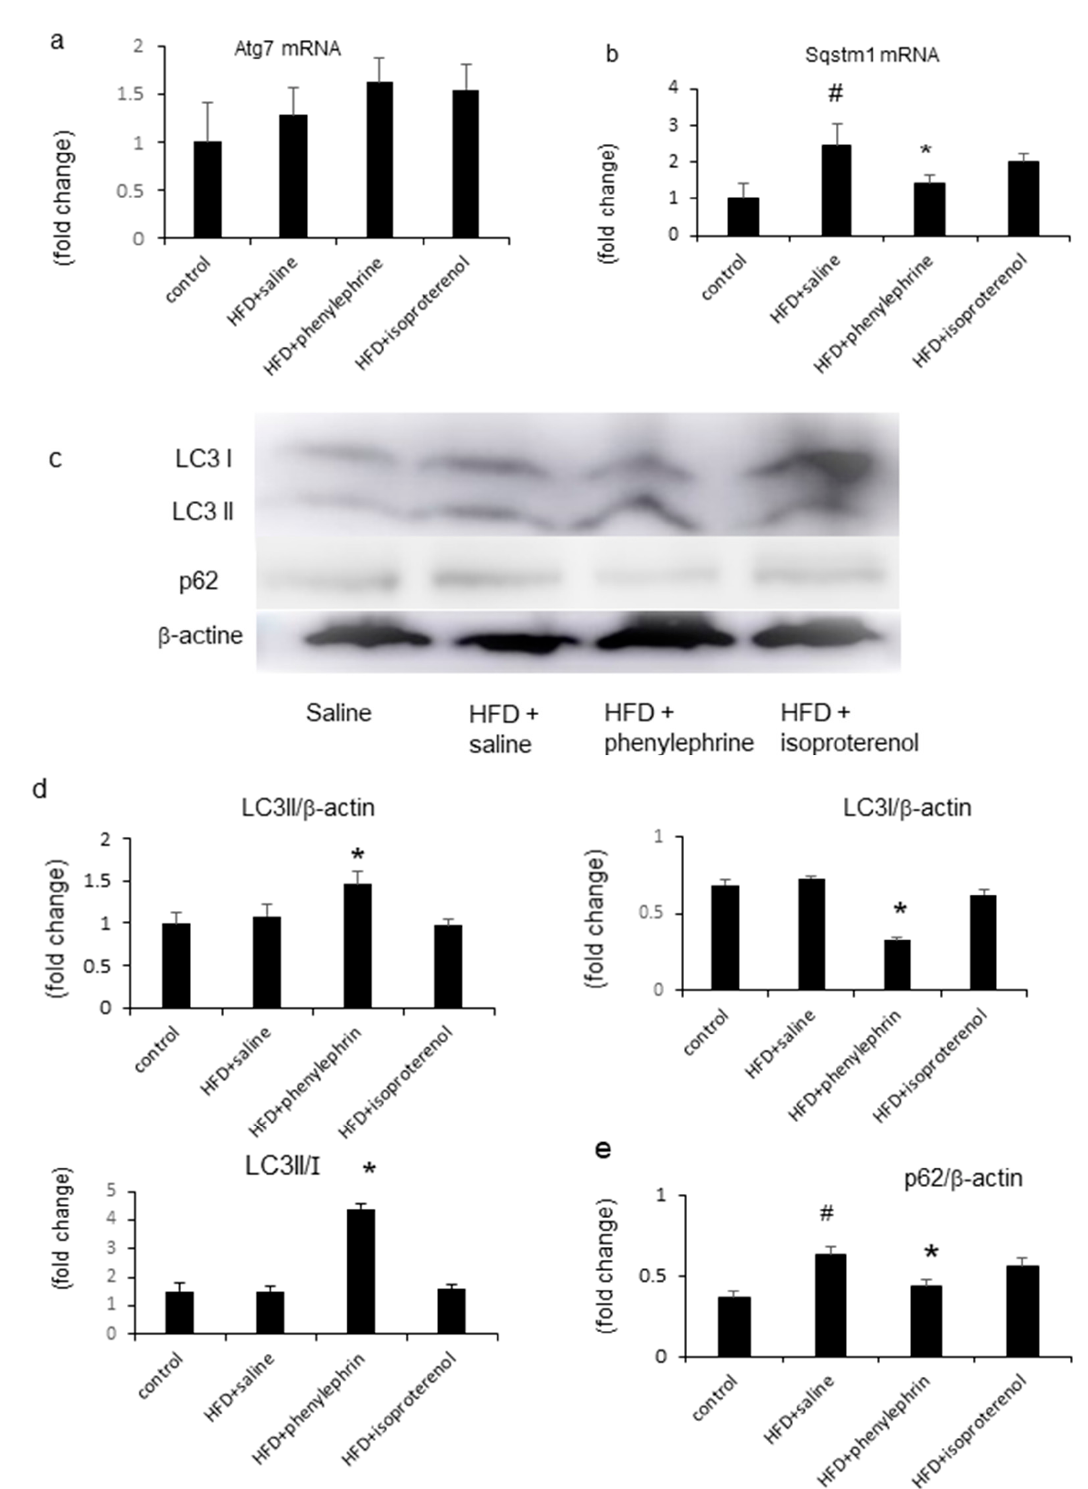
Figure 5. Evaluation of hepatic autophagy-related parameters. Relative mRNA expressions of Atg7 ( a ) and SQSTM1 ( b ). Western blotting autoradiograph images ( c ) and levels ( d , e ) of LC3 and p62 autophagy-related proteins in mice. Statistical analysis was performed using ANOVA. Data are expressed as means ± SE. # p < 0.05 for HFD with saline group compared with the control group. * p < 0.05 for HFD with phenylephrine group compared to HFD with the saline group. 2.6. Hepatic Adrenergic Receptors mRNA and Proteins Mediated by Phenylephrine and Isoproterenol Both control and HFD treatment produced the mRNA and protein of hepatic adrenergic receptors α 1 (ADR α 1) and β 1 (ADR β 1) (figure 6). These proteins’ levels were not significantly changed by HFD. However, ADR α 1 protein levels were higher than ADR β 1 protein levels in the liver (Figure 6).